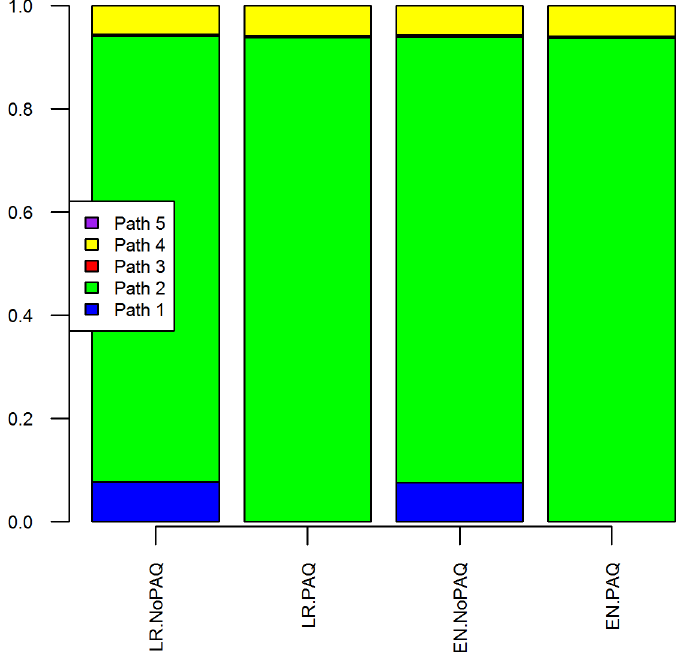
Fig 3. Proportional contribution of different pathways to median overall probability of exporting an undetected infected horse. LR, Low-risk area; EN, Endemic area; NoPAQ, No post-arrival quarantine or PCR; PAQ, Post arrival quarantine and PCR at destination; PCR, real-time reverse transcription polymerase chain reaction